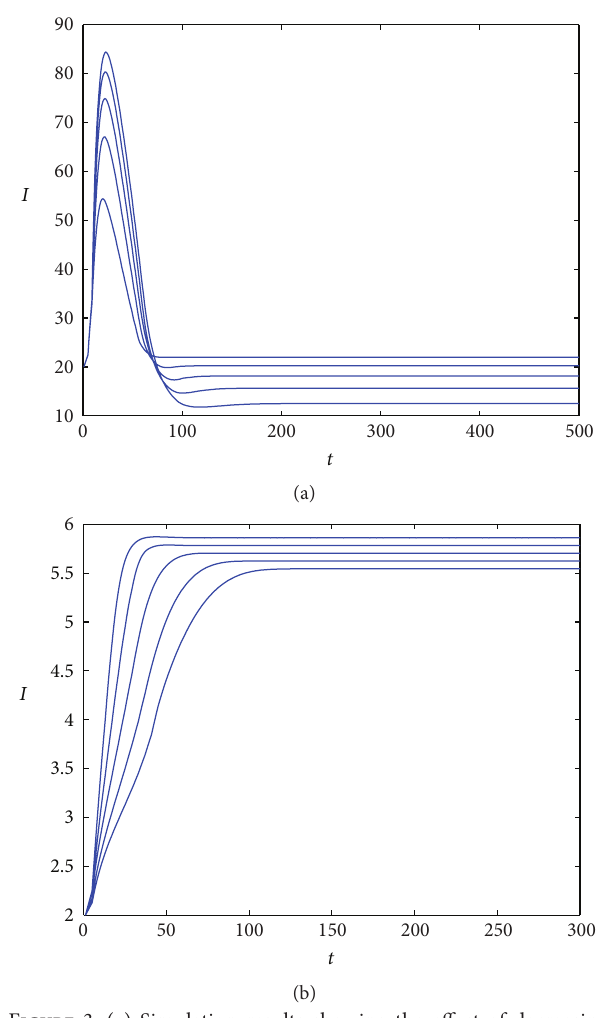
Figure 3: (a) Simulation results showing the effect of decreasing infected pine trees to parameter 𝜇 for 𝜇 = 0.0005, 0.001, 0.0015, 0.002, 0.0025 , and other parameter values are as given in Figure 2(b). (b) Simulation results showing the effect of decreasing infected pine trees to parameter 𝛿 for 𝛿 = 0.008, 0.016, 0.024, 0.032, 0.04 , and other parameter values are as given in Figure